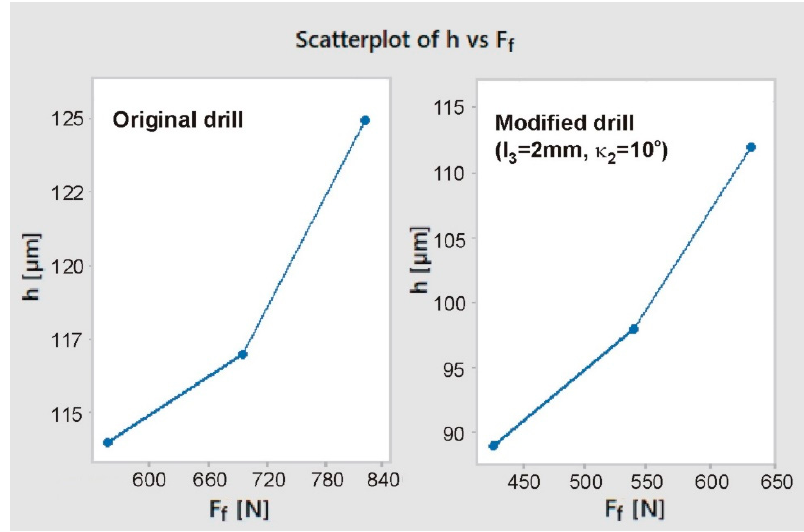
Figure 13. Burr height h as a function of axial drilling force F f .